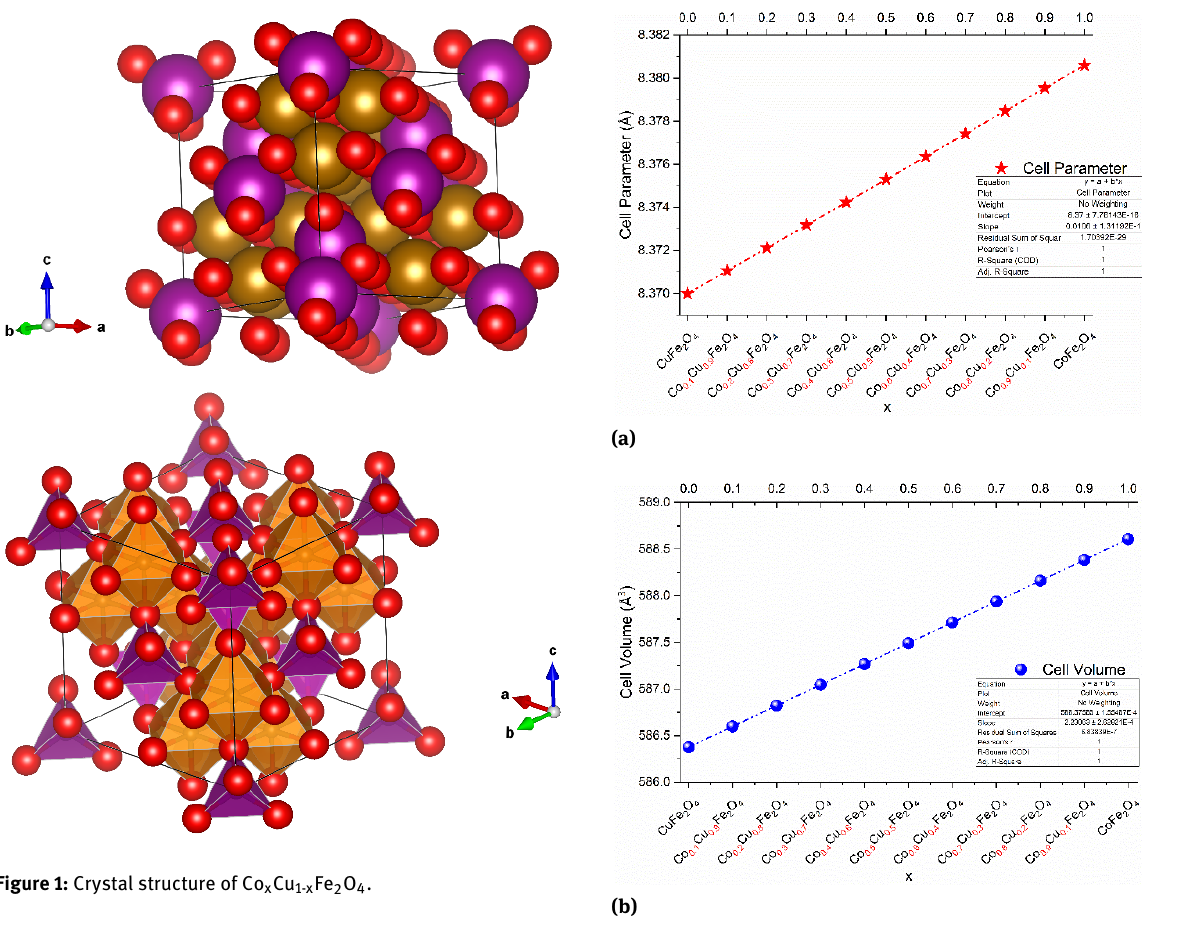
Figure 2: a) Variation of lattice parameter with substitution factor(x); b) Variation of lattice volume with substitution